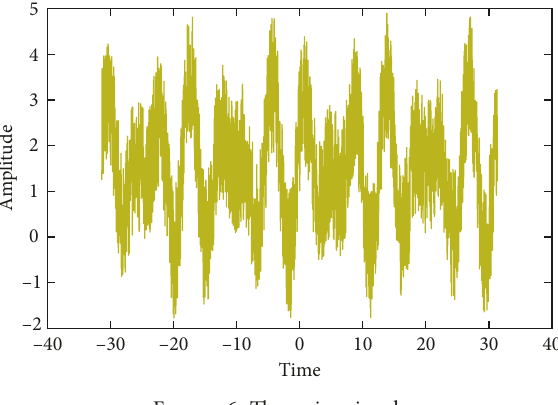
Figure 6: The noisy signal.